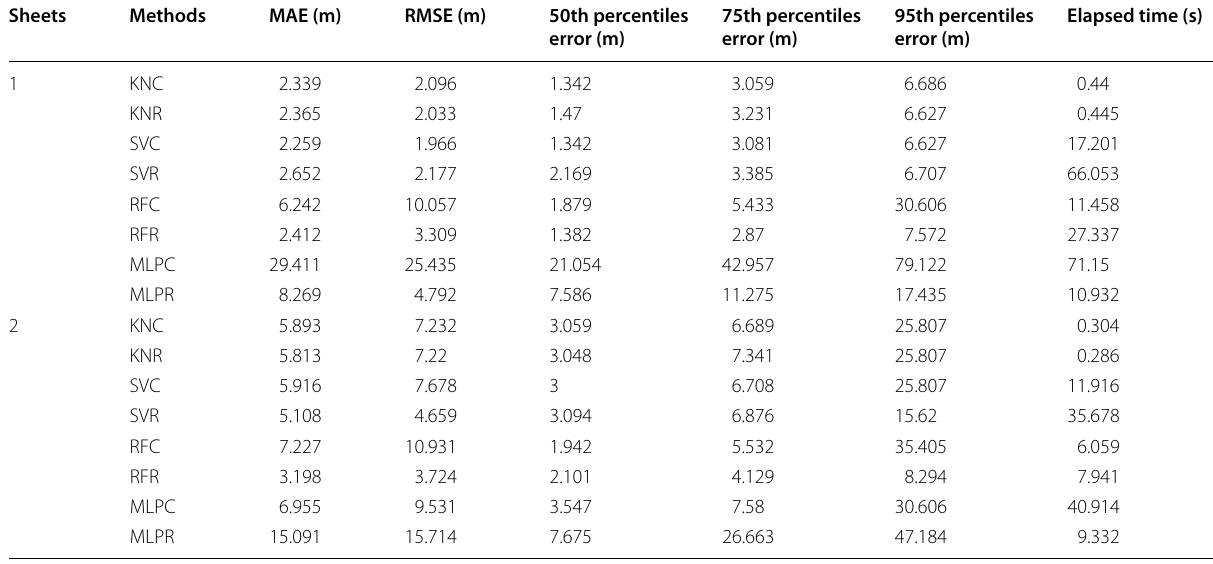
Table 11 Statistics of different methods based on the two sheets in the HCXY building Sheets Methods